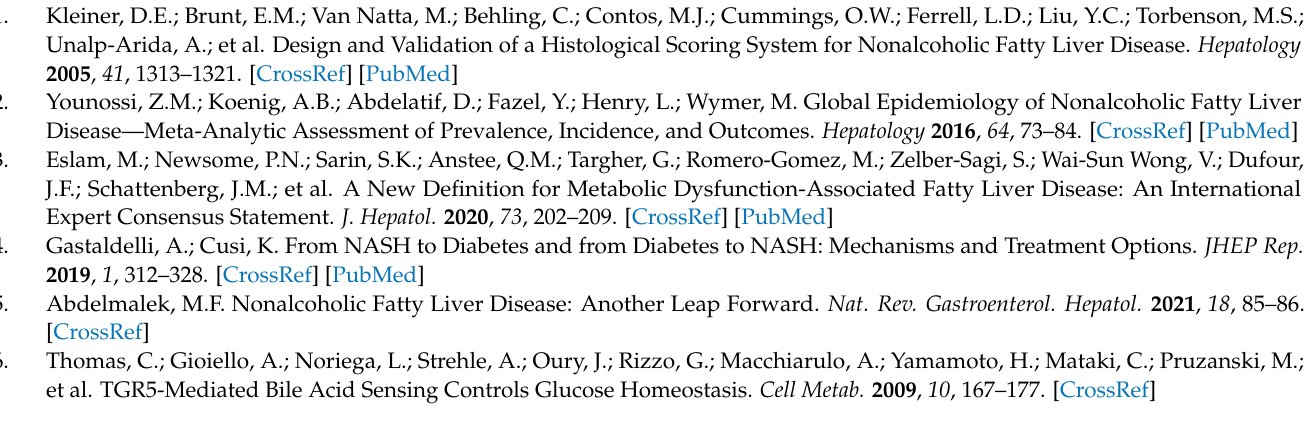
Figure S2: Gene expression of TGR5 in the colon (A) and liver (B) of WT, foz/foz, foz/foz + INT-777 and foz/foz + RO5527239 mice. (C) Volume of bile in the gallbladder of WT, foz/foz, foz/foz